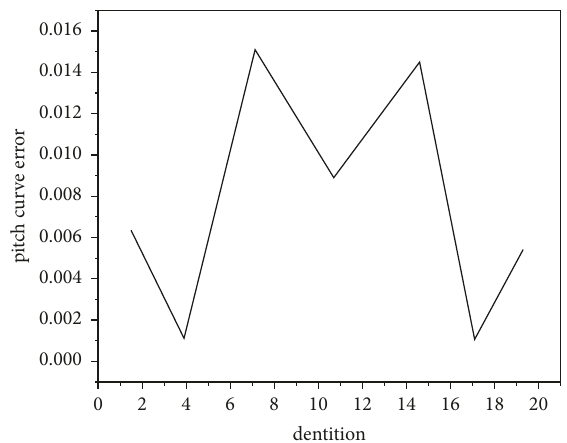
Figure 12: Tooth profile error caused by circular runout of workpiece end face.